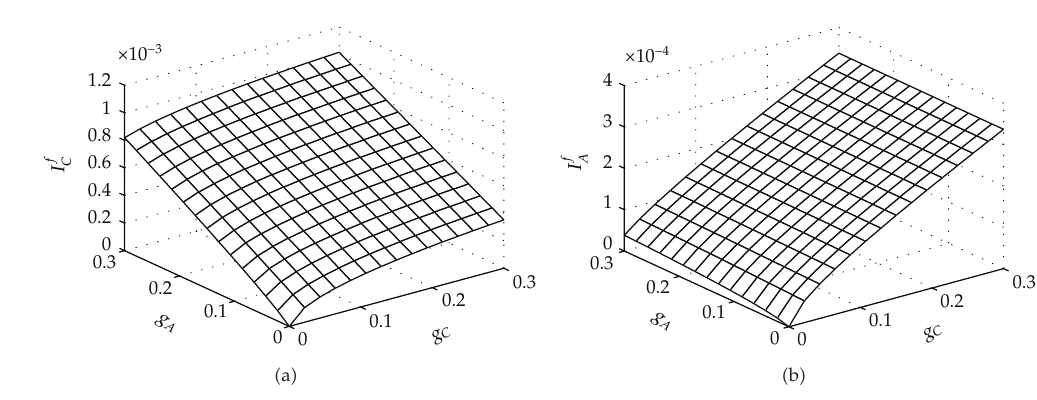
Figure 6: Component I C (cid:5) a (cid:6) and component I A (cid:5) b (cid:6) of endemic equilibria E f . Here, R 0 < 1 when g C (cid:8) g A (cid:8) 0.